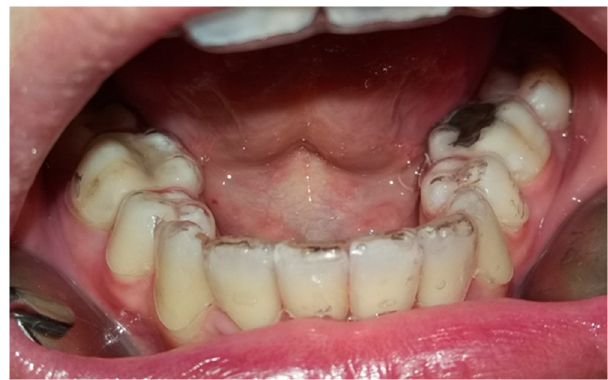
Figure 2. Inferior vacuum-formed retainer used in the study.